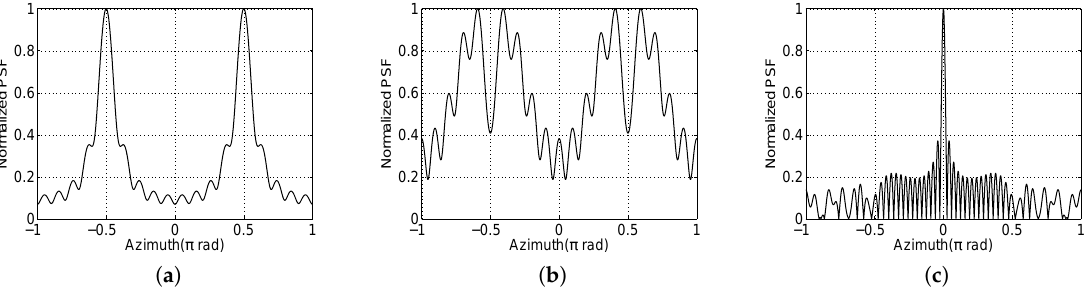
Figure 3. Azimuth profiles of the point spread function (PSF) of the Fourier transform operator with α m = 10 and ka = 10 π . ( a ) Large elevation angle (0.4 π ); ( b ) small elevation angle (0.1 π ); ( c ) small elevation angle but multiple receivers.